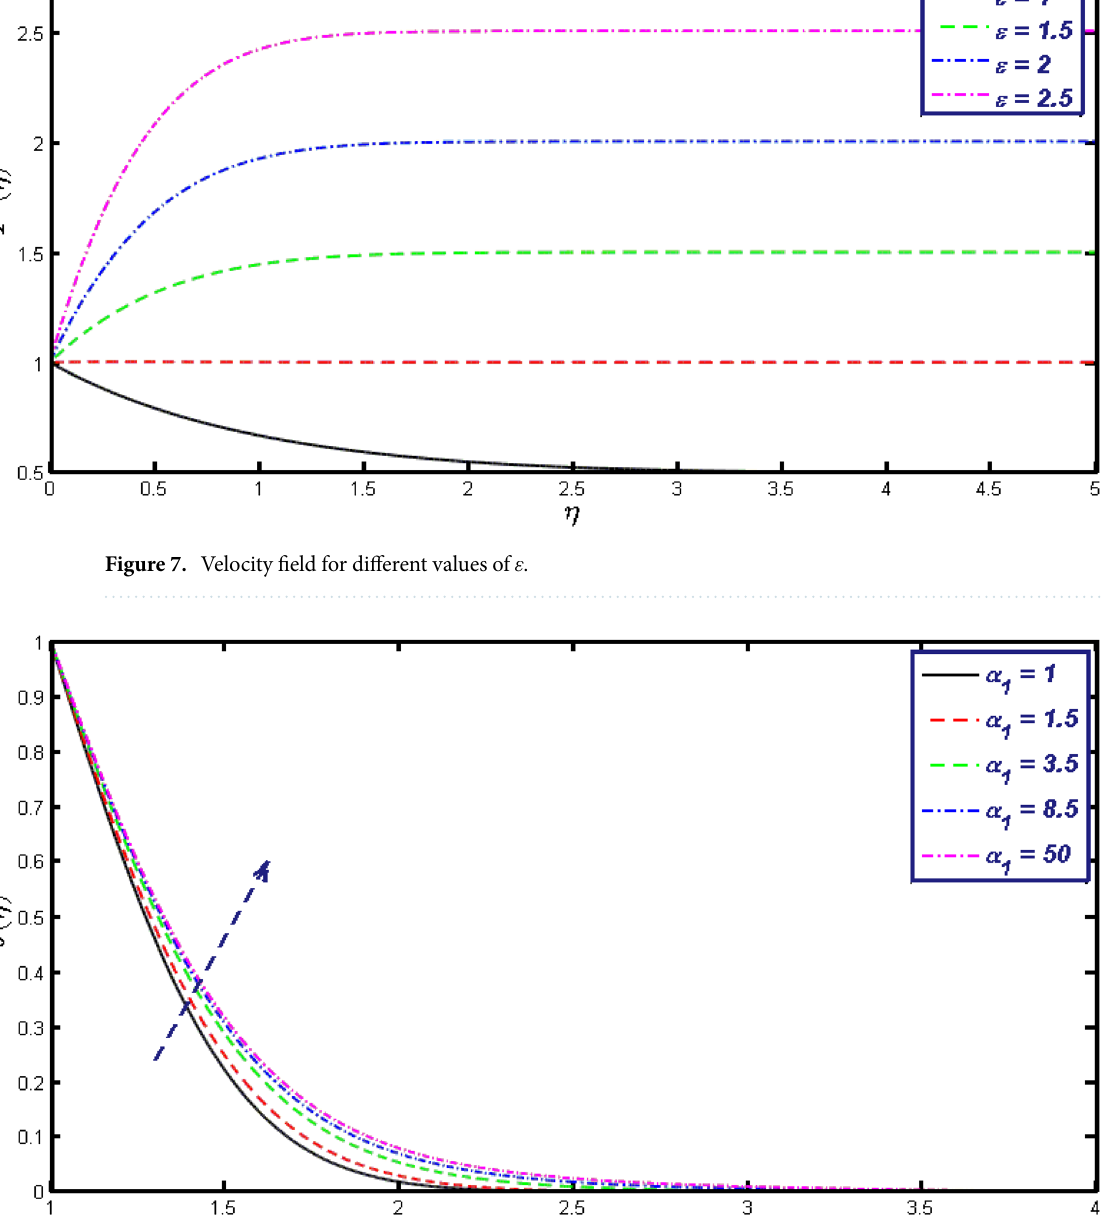
Figure 8. Temperature field for different values of α 1